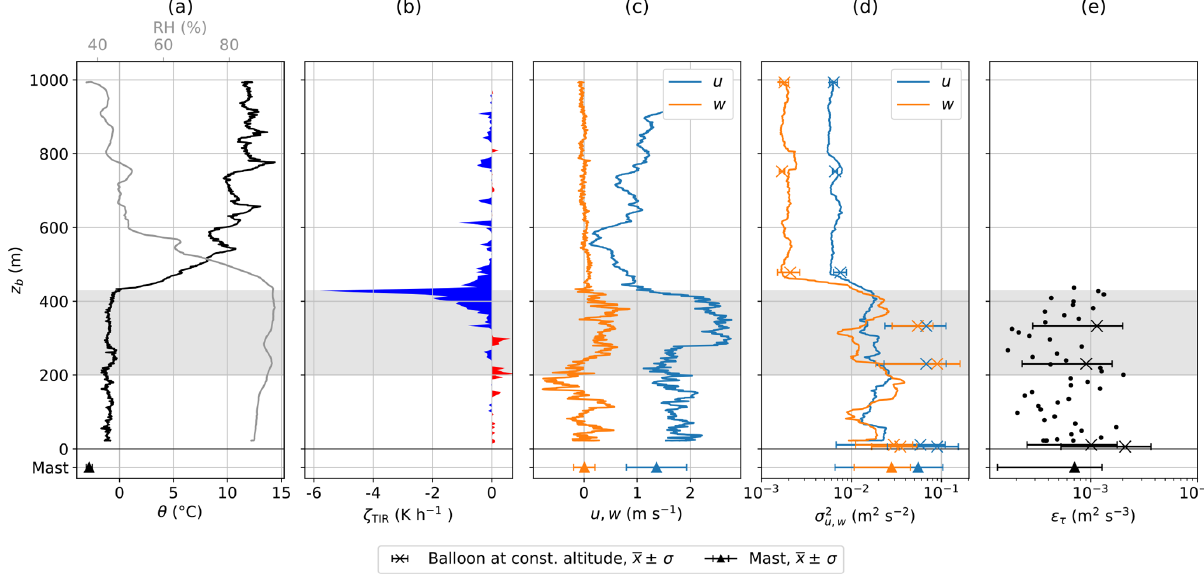
Figure 10. Vertical profiles of potential temperature θ and relative humidity RH (a) , TIR heating rate ζ TIR (b) , horizontal wind u and vertical wind w (c) , local wind velocity variance σ u,w (d) , and the local dissipation rate ε τ (e) observed on 5 June 2017. Solid lines and small dots show slant profile data measured during the ascent (60s running time window for variances, nonoverlapping time segments of 10s for dissipation rate). Crosses and corresponding horizontal bars in panels (d) and (e) show mean and standard deviation of dissipation rate and variances for measurements at constant altitude (segments of typically 10min) obtained during the descent. Averaged ground-based measurements at the meteorological mast are shown as triangles with the standard deviation indicated by horizontal bars. The cloud extent is indicated by gray